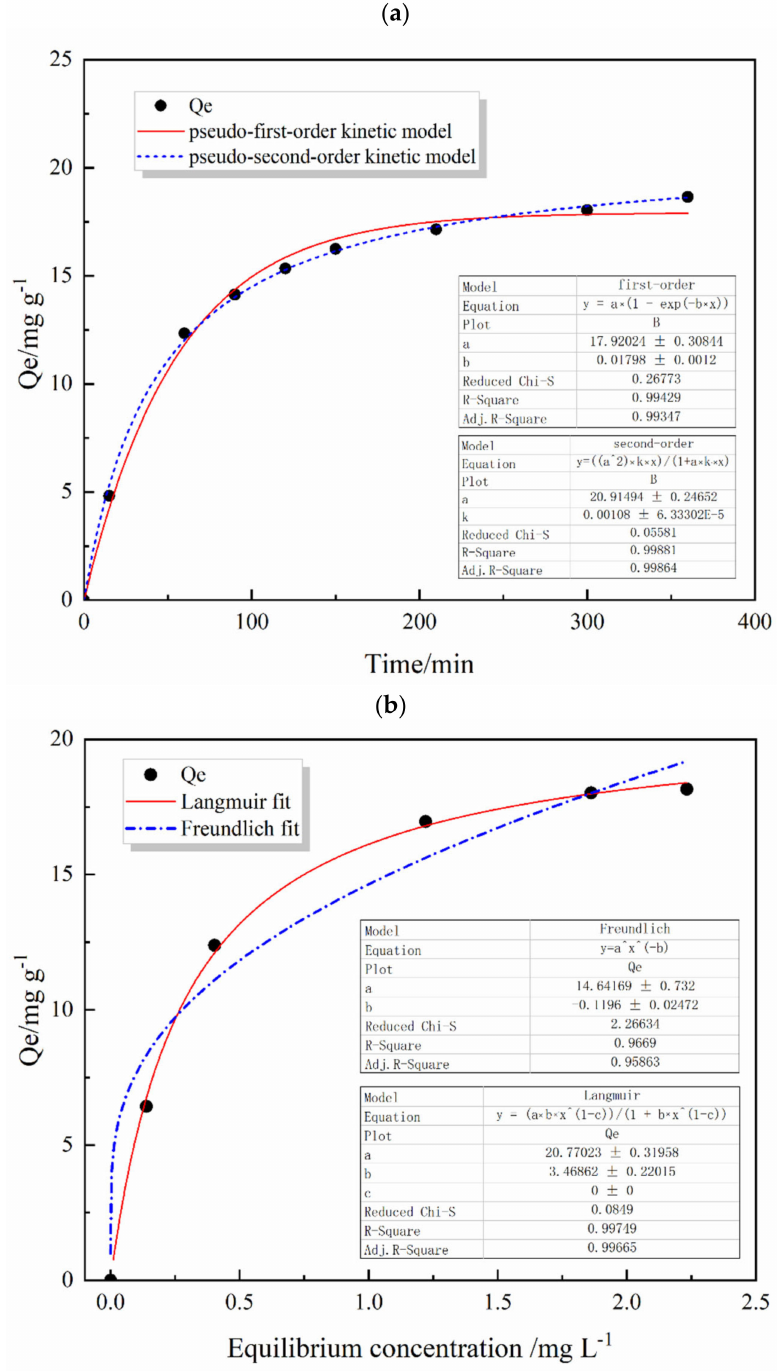
Figure 7. ( a ) Kinetic of phosphate adsorption on La − CZ; ( b ) Isotherm of phosphate adsorption on La −